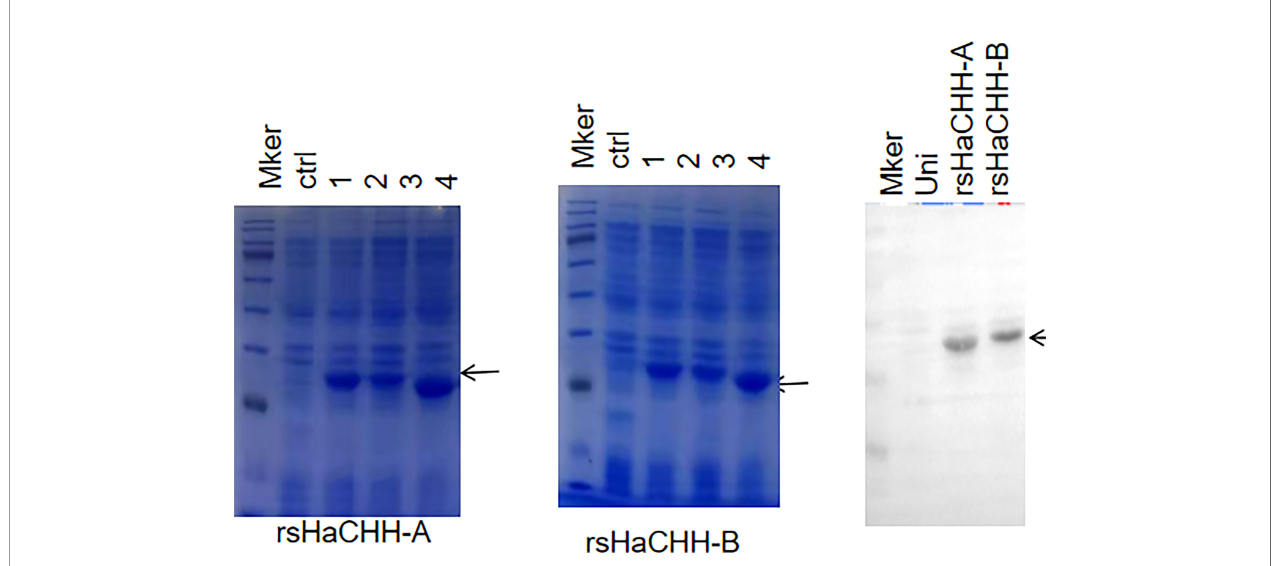
FIGURE 8 | SDS-PAGE (12.5%) analysis of the prokaryotic ( Escherichia coli ) expression of the recombinant proteins rsHaCHH-A ( left ) and rsHaCHH-B ( middle ) after induction by IPTG. Ctrl : uninduced ( uni ); lanes 1 – 4 : induced and sampled at 2, 4, 6, and 8 h, respectively. Western blot detection of the poly-His-tagged recombinant proteins sHaCHH-A and sHaCHH-B ( arrow ). Right : The antibody used is the anti-polyhistidine peroxidase conjugate antibody (Sangon Biotech, Shanghai,